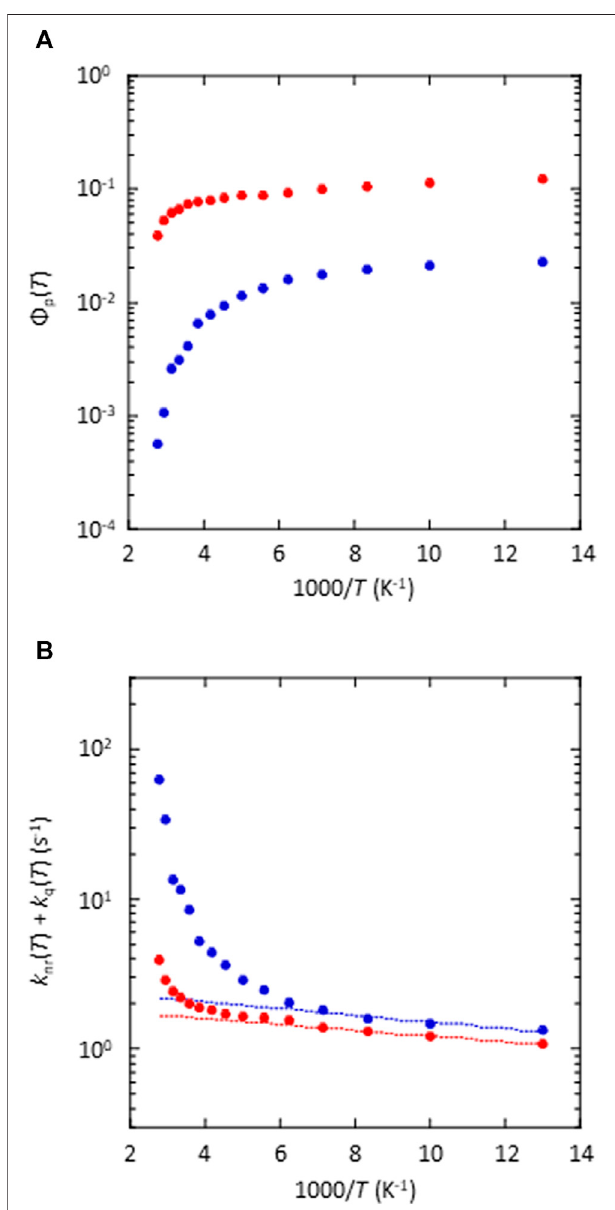
FIGURE 5 | Temperature dependence of phosphorescence and nonradiative deactivation of amorphous (blue) and crystalline (red) 5 wt% ( S )- BINAP-doped ( S )-H 8 -BINAP. (A) Temperature dependence of Φ p ( T ). The excitation wavelength was 330 nm. (B) Temperature dependence of k nr (T)+ k q (T). Thedashed lines are fi ttinglines for k nr ( T ),which wasdetermined according to the exponential function for data from 77K to 140 K. (( S )-BINAP (cid:1) ( S )-( − )-2,2 ′ -bis(diphenylphosphino)-1,1 ′ -binaphthyl ( S )-H bis(diphenylphosphino)-5,5 ′ ,6,6 ′ ,7,7 ′ ,8,8 ′ -octahydro-1,1 ′ -binaphthyl).